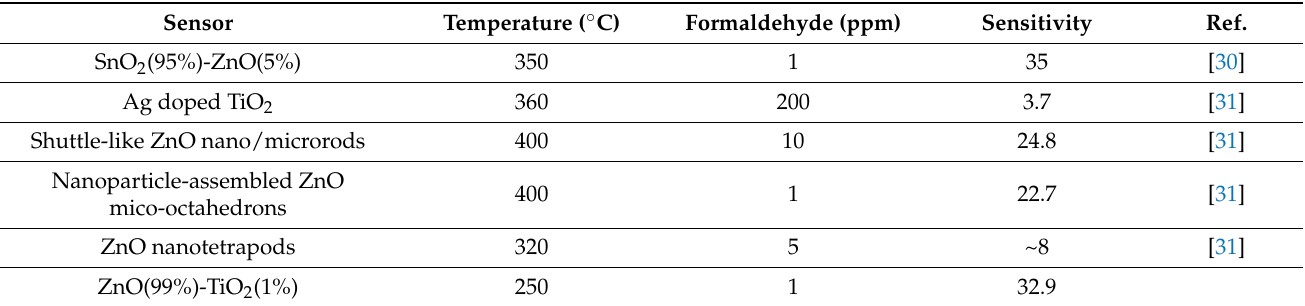
Table 3. Formaldehyde gas sensitivity of ZnO-based gas sensor and TiO 2 gas sensor with different